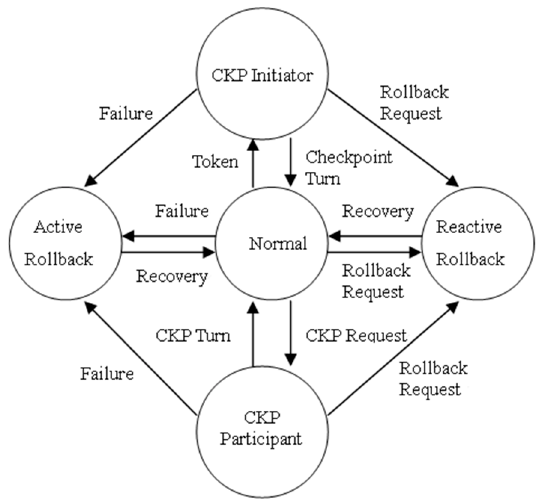
Figure 8. The transition of states.